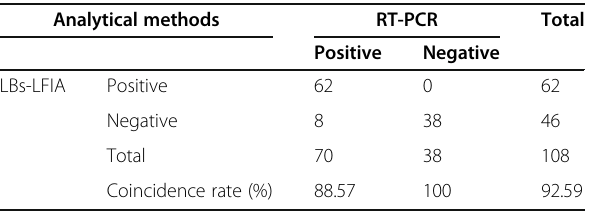
Table.3 Comparison of the analysis results between LBs-LFIA and